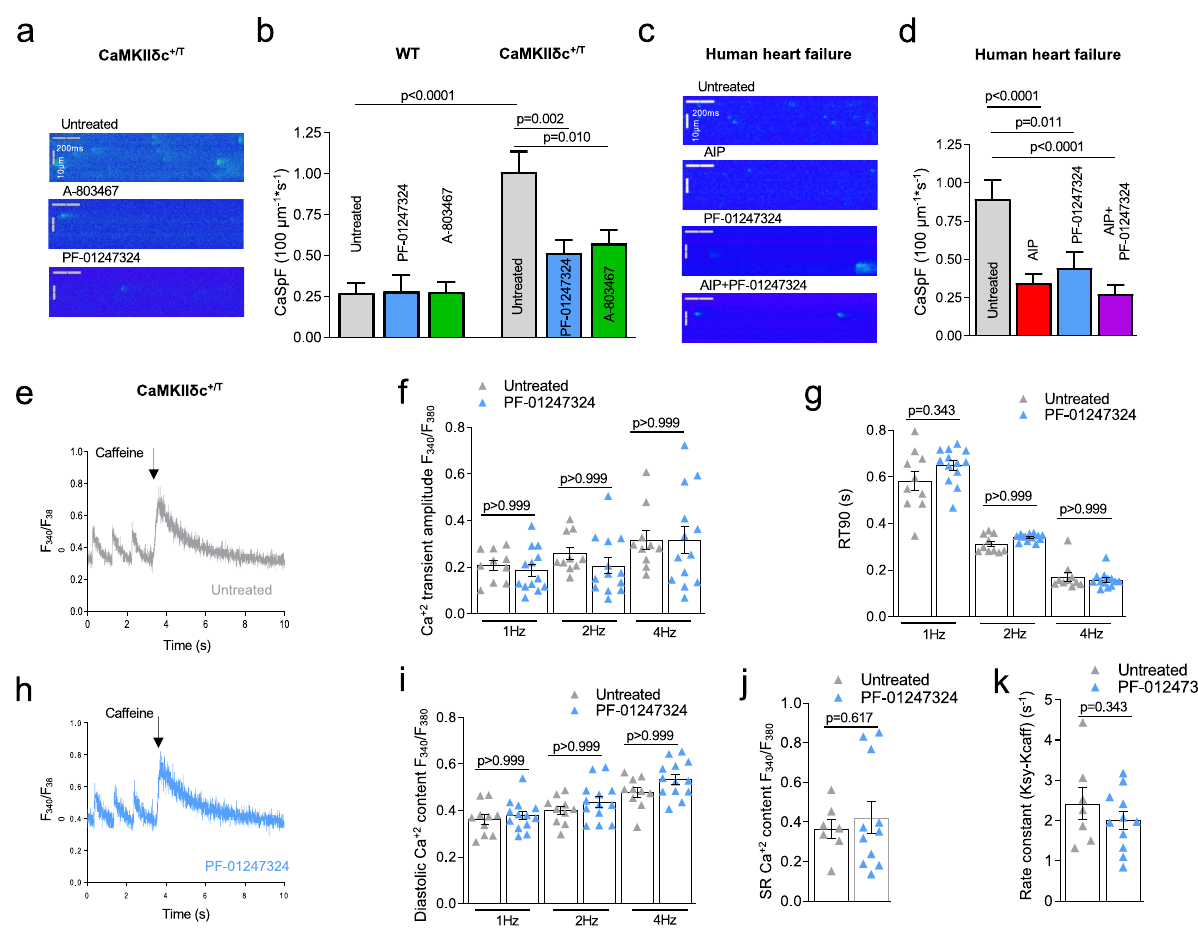
Fig. 3 Effects Na V 1.8 inhibition on intracellular Ca 2 + handling. a Representative line scan images of CaMKII δ c + /T ventricular cardiomyocytes. b CaSpF data shown as mean ± SEM for wildtype (WT) (untreated: n = 58 cells/4 mice; PF-01247324: n = 41 cells/4 mice; A-806467: n = 41 cells/4 mice) and CaMKII δ c + /T (untreated: n = 122 cells/8 mice; PF-01247324: n = 105 cells/7 mice; A-806467: n = 101 cells/8 mice). Data were analyzed by one-way ANOVA with post hoc Bonferroni ’ s correction. c Representative line scan images of human failing ventricular cardiomyocytes. d Data shown as mean ± SEM (untreated: n = 123 cells/14 patients; Autocamtide-2-related inhibitory peptide (AIP): n = 105 cells/15 patients; PF-01247324: n = 59 cells/10 patients; AIP + PF-01247324 = 89 cells/13 patients). Data were analyzed by one-way ANOVA with post hoc Bonferroni ’ s correction, Probability vs. untreated. e Representative Ca 2 + transients stimulated at 1 Hz and caffeine-induced Ca 2 + transients in ventricular cardiomyocytes from CaMKII δ c + /T under untreated conditions. f Mean data ± SEM show no effect of PF-01347324 treatment on Ca 2 + transient amplitude at 1.0, 2.0, and 4.0 Hz stimulation ( n = 13 cells/5 mice) compared to untreated ( n = 10 cells/5 mice). g Ca 2 + -transient decay (90% of Ca 2 + -removal) RT90 was unchanged in PF- 01347324-treated cells ( n = 11 cells/5 mice) compared to untreated ( n = 8 cells/5 mice). Data were presented as mean values ± SEM. h Representative Ca 2 + transients stimulated at 1 Hz and caffeine-induced Ca 2 + transients in ventricular cardiomyocytes from CaMKII δ c + /T treated with PF-01247324. i Diastolic Ca 2 + after addition of PF-01347324 ( n = 13 cells/5 mice) compared to untreated cells ( n = 10 cells/5 mice) at different stimulation frequencies was unchanged (one-way ANOVA with post hoc Bonferroni ’ s correction, Fig. 3f, g, i). Data were presented as mean values ± SEM. j Mean and individual values ± SEM of caffeine-induced Ca 2 + transients (untreated: n = 7 cells/4 mice, PF-01247324: n = 11 cells/5 mice) did not differ between the groups (Student ’ s t -test). k Ca 2 + -reuptake into the SR was not affected by inhibition of Na V 1.8 (untreated: n = 7 cells/4 mice, PF-01247324: n = 11 cells/5 mice), analyzed by Student ’ s t -test. Data were presented as mean values±